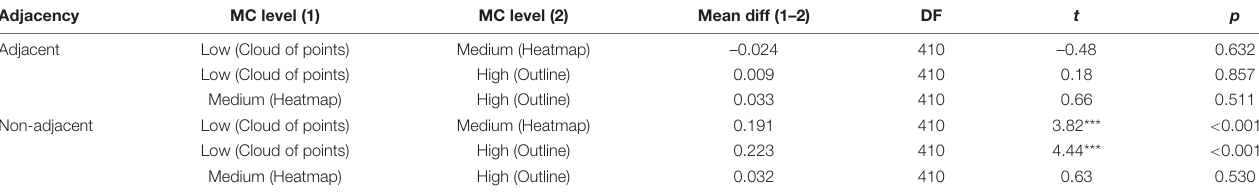
TABLE 3 | Post hoc comparisons of the interaction between adjacency and MC on confidence. Adjacency